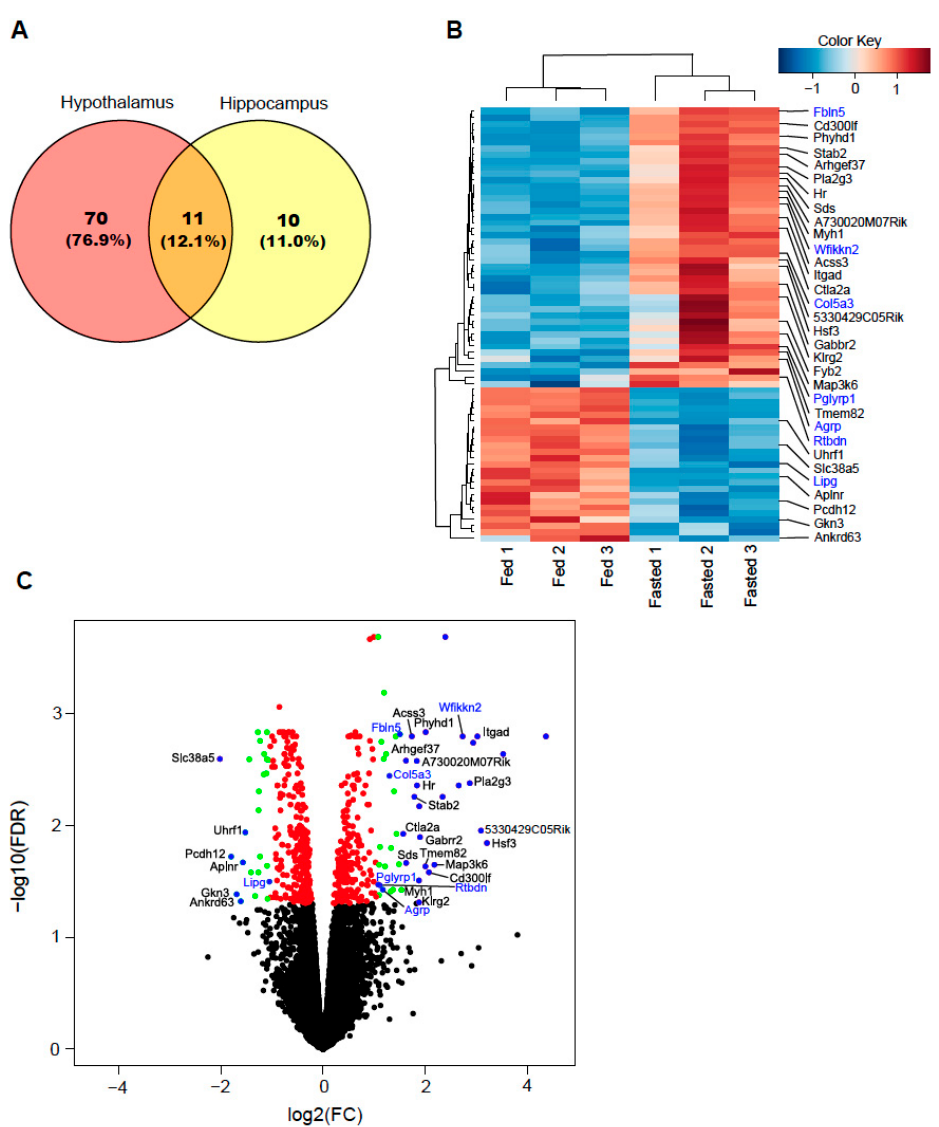
Figure 1. Overview of differential gene expression analysis between fed and fasted mice. ( A ) Venn diagram showing the number of overlapping genes between the hypothalamus and hippocampus regions in genes with false discovery rate (FDR) ≤ 0.05 and absolute log2 fold change (abs(log2FC)) > 1.0. ( B ) Heatmap demonstrating 70 differentially expressed genes (DEGs) with FDR ≤ 0.05 and abs(log2FC) > 1.0 in only hypothalamus, excluding 11 common genes between the hypothalamus and hippocampus. The genes annotated to the right of the heatmap are those with FDR ≤ 0.05 and abs(log2FC) > 1.5, and the blue color text represents the secretory-related gene. ( C ) Volcano plot depicting DEGs and distribution in hypothalamus compared with those of fed mice. The x-axis is log2FC of individual genes and y-axis is the negative logarithm of their FDR to base 10( − log10(FDR)). The black dots indicate genes with FDR > 0.05. The red dots indicate genes with FDR ≤ 0.05 and abs(log2FC) ≤ 1.0. The green dots indicate DEGs with FDR ≤ 0.05 and abs(log2FC) > 1.0 in fasted mice compared with those of fed mice. The blue dots indicate genes identified with FDR ≤ 0.05 and abs(log2FC) > 1.5, and secretory-related genes in fasted mice compared with those of fed mice. The blue color text represents the secretory-related gene.